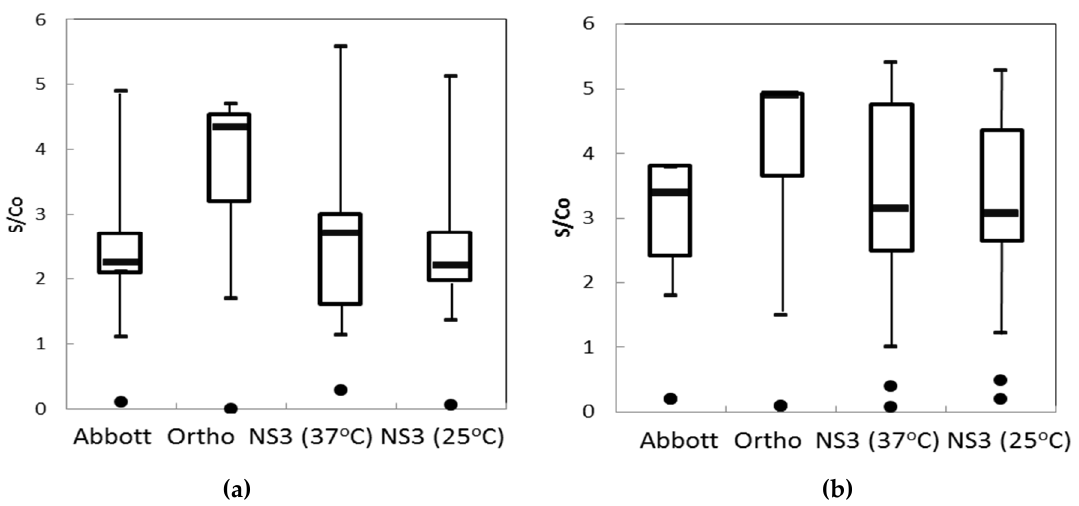
Figure 7. Box plots for ELISA specificity comparison of HCV NS3 antigens and two commercial kits. The experiments were performed using the Anti-HCV Low Titer Performance Panel PHV 105 (M) ( a ) and the Anti-HCV Mixed Titer Panel PHV 205 ( b ) as the standard specimens. The specimens of 7A include 7 positive samples, 1 negative sample ( ● ), and 5 intermediate samples. The specimens of 7B include 20 positive samples, 2 negative sample ( ● ), and 3 intermediate.